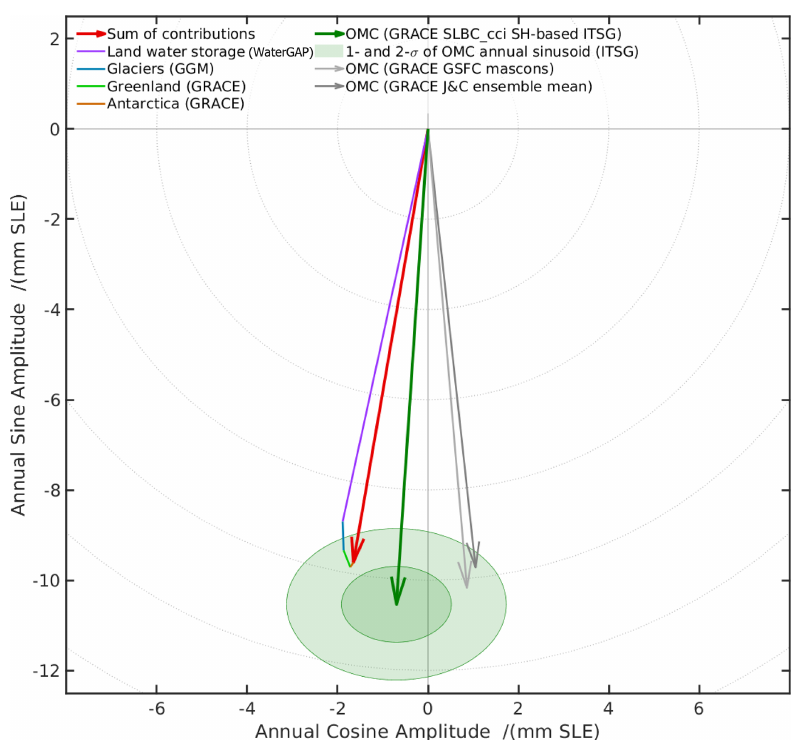
Figure 9. Phase diagram of annual sine and cosine amplitudes of elements of the ocean-mass budget. Bold red vector: sum of contributions (using GRACE-based estimates for Greenland and Antarctica). Coloured thin lines: individual contributions (see legend). Bold dark-green vector: GRACE ocean-mass change (OMC) SLBC_cci solution based on GRACE ITSG-Grace2018, together with uncertainty ellipses. Thin grey vectors: external GRACE OMC solutions (GSFC mascons and Johnson and Chambers – J&C – ensemble mean). The phase difference between the red and the dark-green vector corresponds to